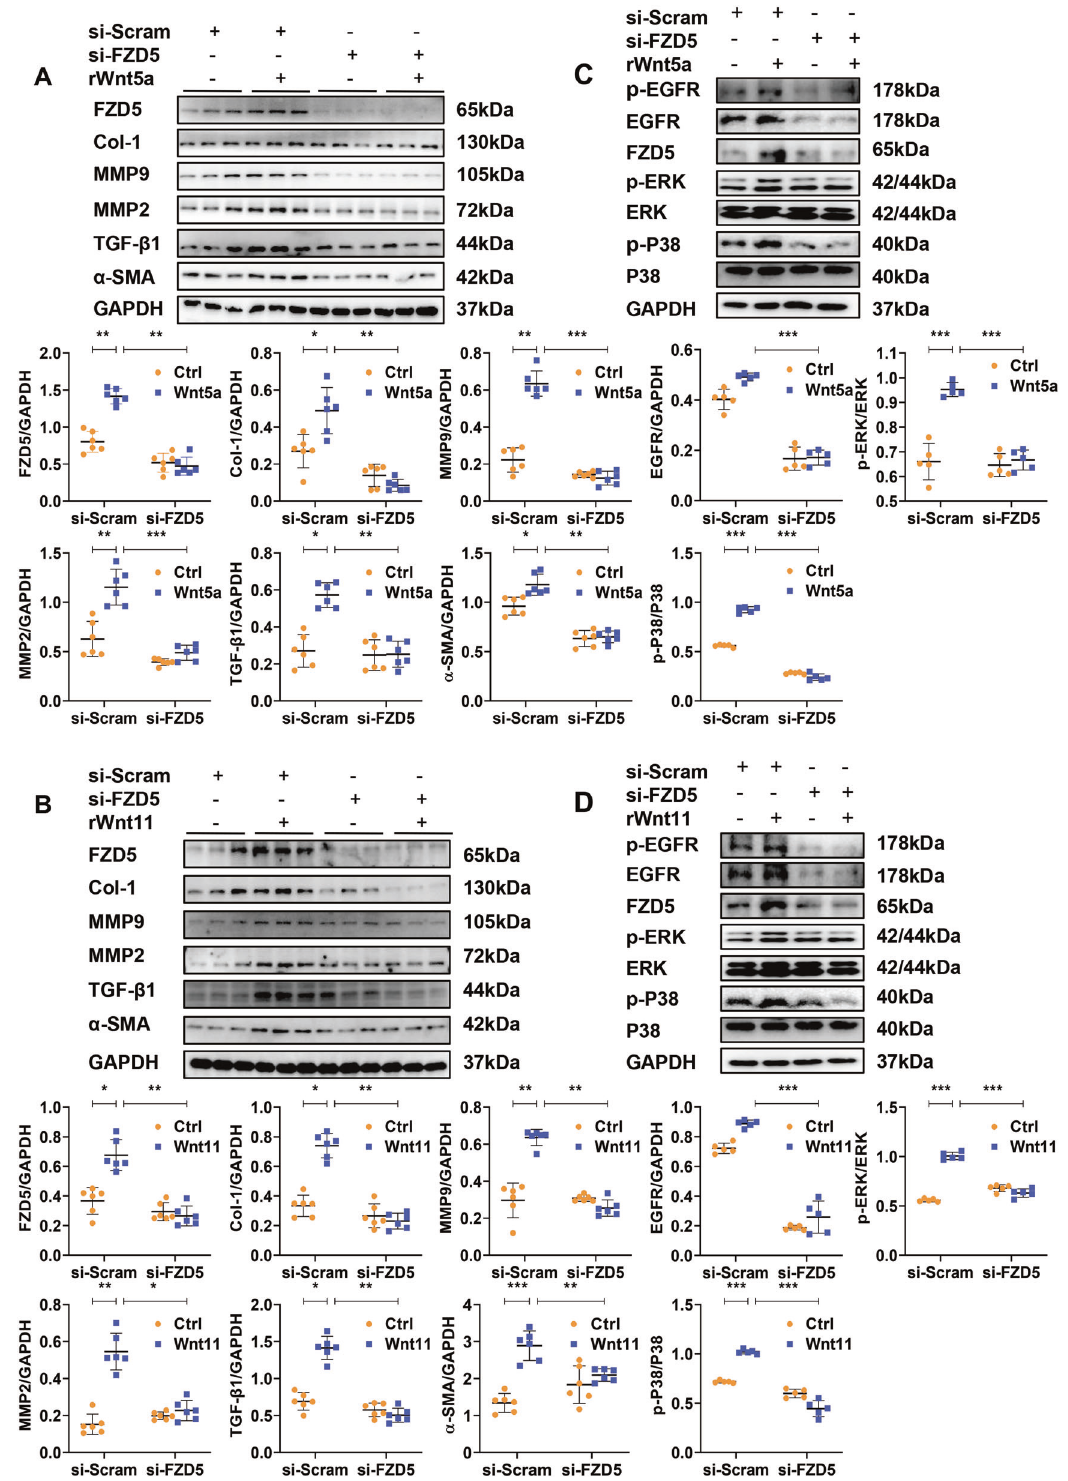
Fig. 8 SiRNA-FZD5 attenuates the activation of neonatal rat cardiac fi broblasts induced by Wnt5a or Wnt11. A , B Western blot analysis of FZD5, Col-1, α -SMA, MMP9, MMP2, and TGF- β 1 expression in cardiac fi broblasts. Si-RNA-FZD5 (si-FZD5) or si-RNA-scramble (si-Scram) was treated with fi broblasts for 48 h, then exogenous recombinant rat Wnt5a (rWnt5a) or Wnt11 (rWnt11) were added into cultured fi broblasts for 24 h for further analysis. n = 6/group. C , D Western blot analysis of p-EGFR, EGFR, p-ERK, p-P38, and FZD5 levels in cardiac fi broblasts. Si-RNA- FZD5 (si-FZD5) or si-RNA-scramble (si-Scram) was treated into fi broblasts for 48 h, then exogenous recombinant rat Wnt5a (rWnt5a) or Wnt11 (rWnt11) were added into cultured fi broblasts for 30 min for further analysis. n = 5/group. All data were shown as mean ± SEM; * P < 0.05, ** P < 0.01, *** P <